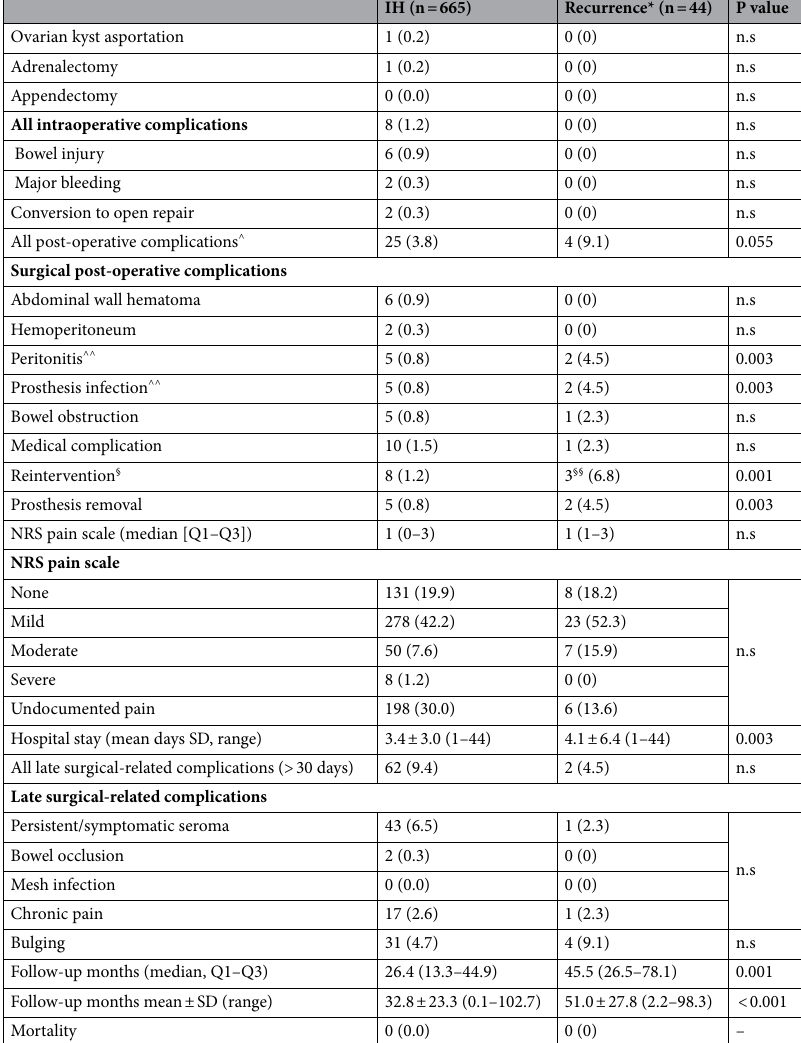
Table 4. Univariable analysis of independent risk factors and relative risk of IH recurrence. Patient baseline demographic, clinical and hernia characteristics, intraoperative, early post-operative and long-term data for IH subgroup with Kaplan–Meier survival analysis and identification of risk factors for recurrence. Number of patients (n = 665), number of recurrences* (n = 44) and p value. Data presented were n (%), unless specified. Q1 ; first quartile, Q3 ; third quartiles; BMI , body mass index; ASA , American Society of Anesthesiologists; COPD , chronic obstructive pulmonary disease; n.s. , not significative. *Comparison with all patients